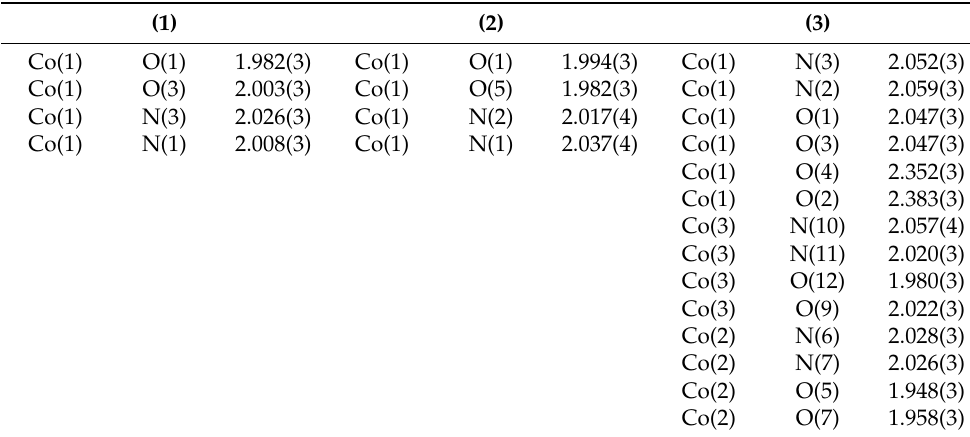
Table 2. Selected bond distances (Å) for ( 1 )–( 3